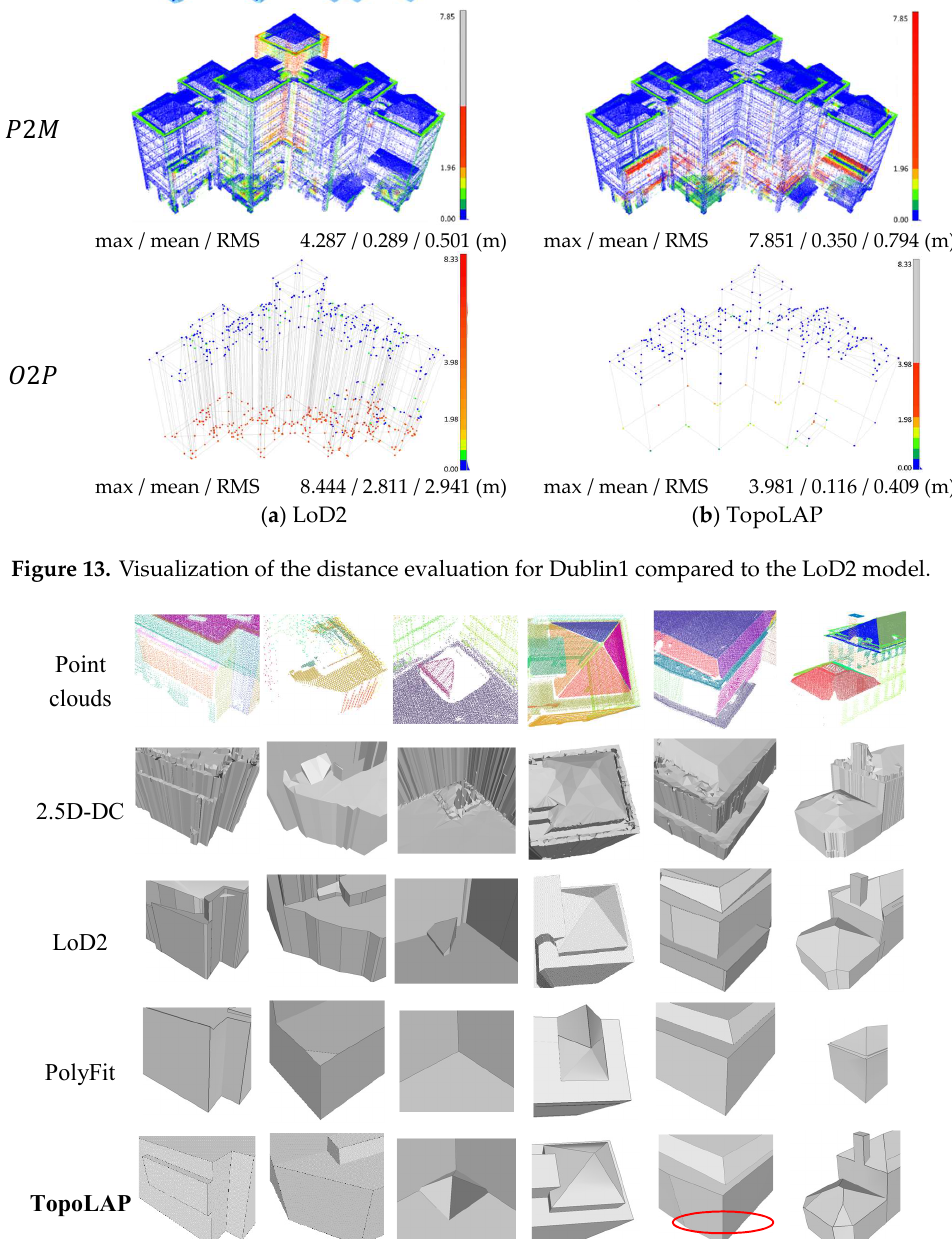
Figure 14. Comparative results of selected details.